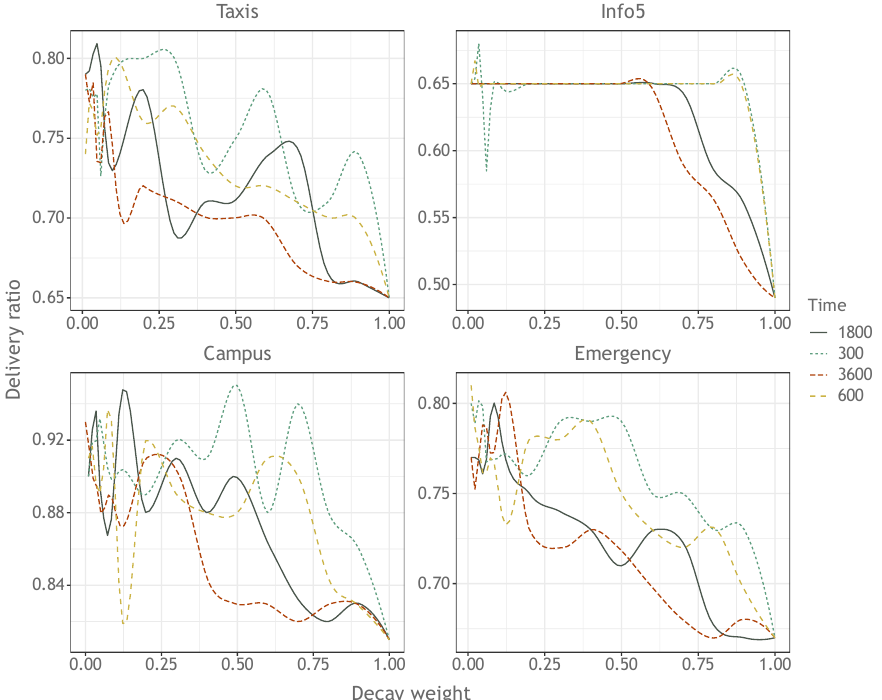
Figure 17. Tendency of the delivery ratio when combining different decay percentages at different times per